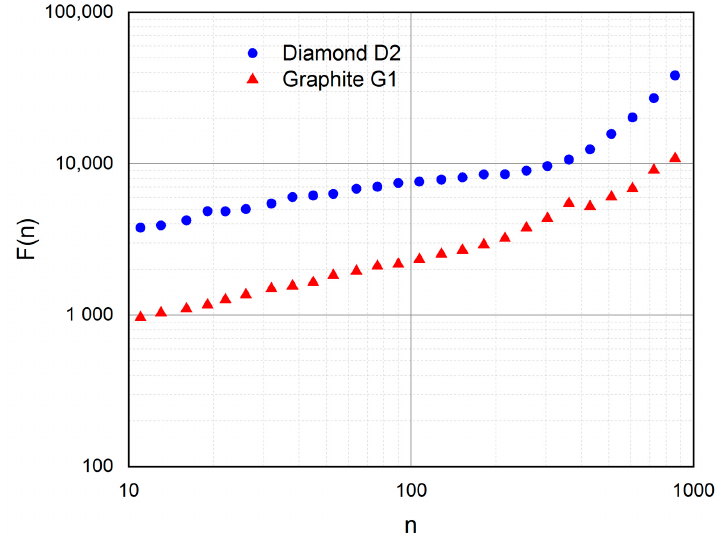
Figure 1. Scale invariance regions of diamond and graphite according to DFA